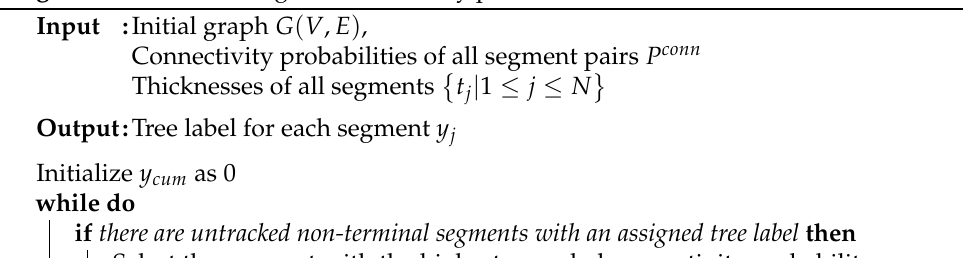
Algorithm 1: Tree tracing via connectivity